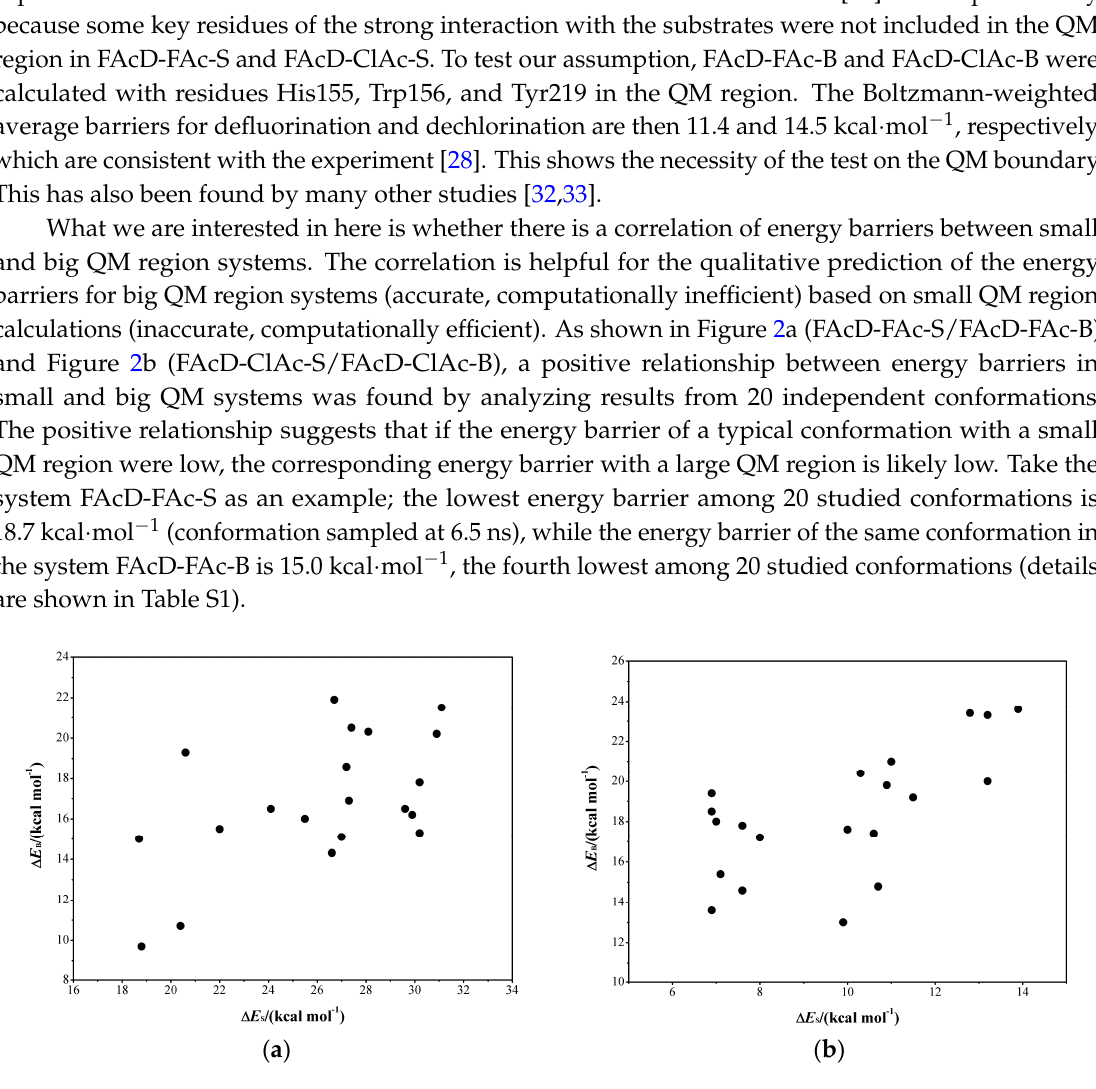
Figure 2. The correlation of energy barriers between systems ( a ) FAcD-FAc-S and FAcD-FAc-B and systems ( b ) FAcD-ClAc-S and FAcD-ClAc-B.